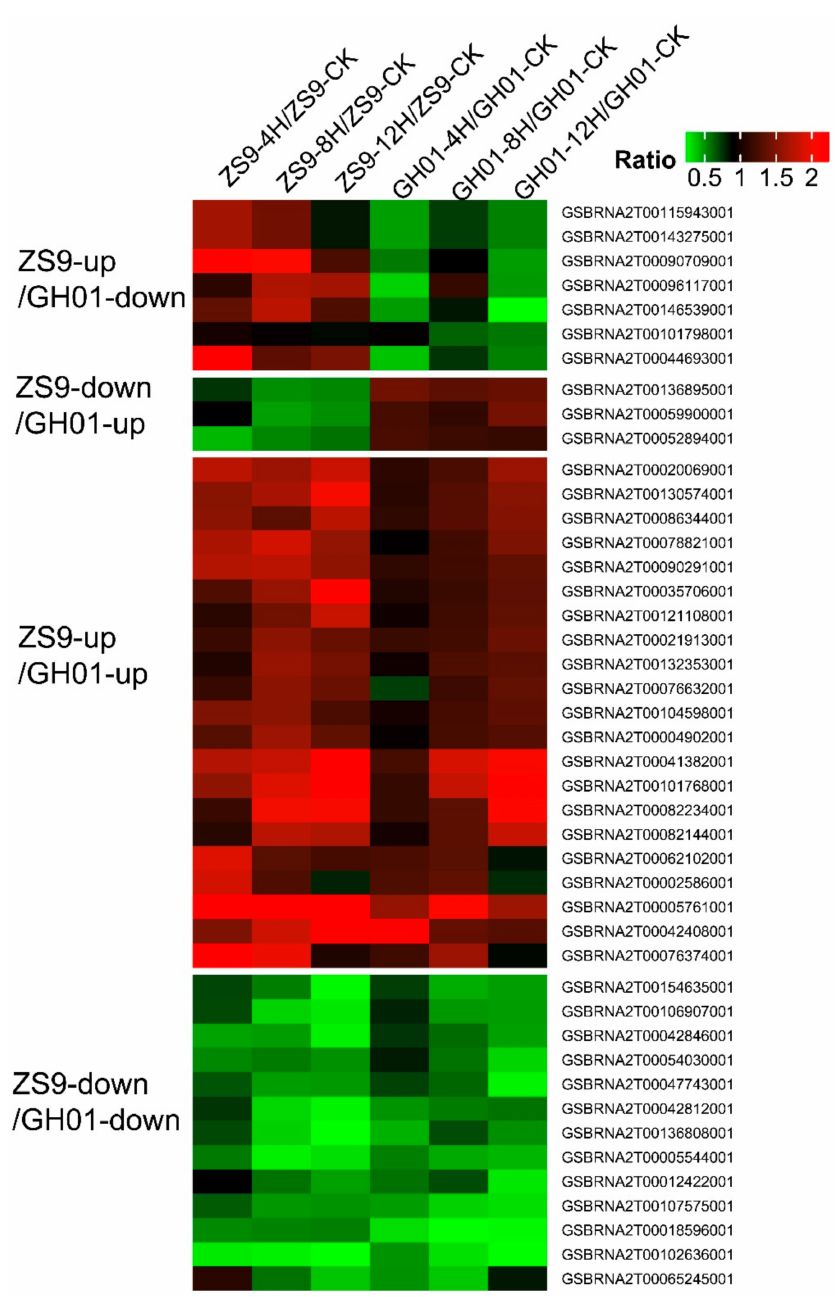
Figure 7. Heat map of the overlapped proteins between ZS9 and GH01 are clustered based on the differentially expressed levels. The original ratios (signal value after waterlogging stress/signal value before waterlogging stress) are color-coded, with green and red denoting decreased and increased expression,